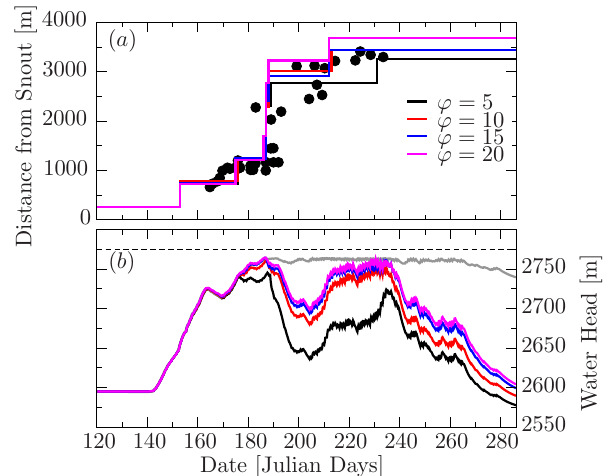
Fig. 9. Same as Fig. 8 but with varying leakage length scales. The grey line in (b) is the IDS water head for a simulation without the EPL. Simulations are performed with a constant IDS transmis- sivity T i = 1 . 6 × 10 − 3 m 2 s − 1 and a constant EPL transmissivity T e = 7 . 9 × 10 − 2 m 2 s − 1 .